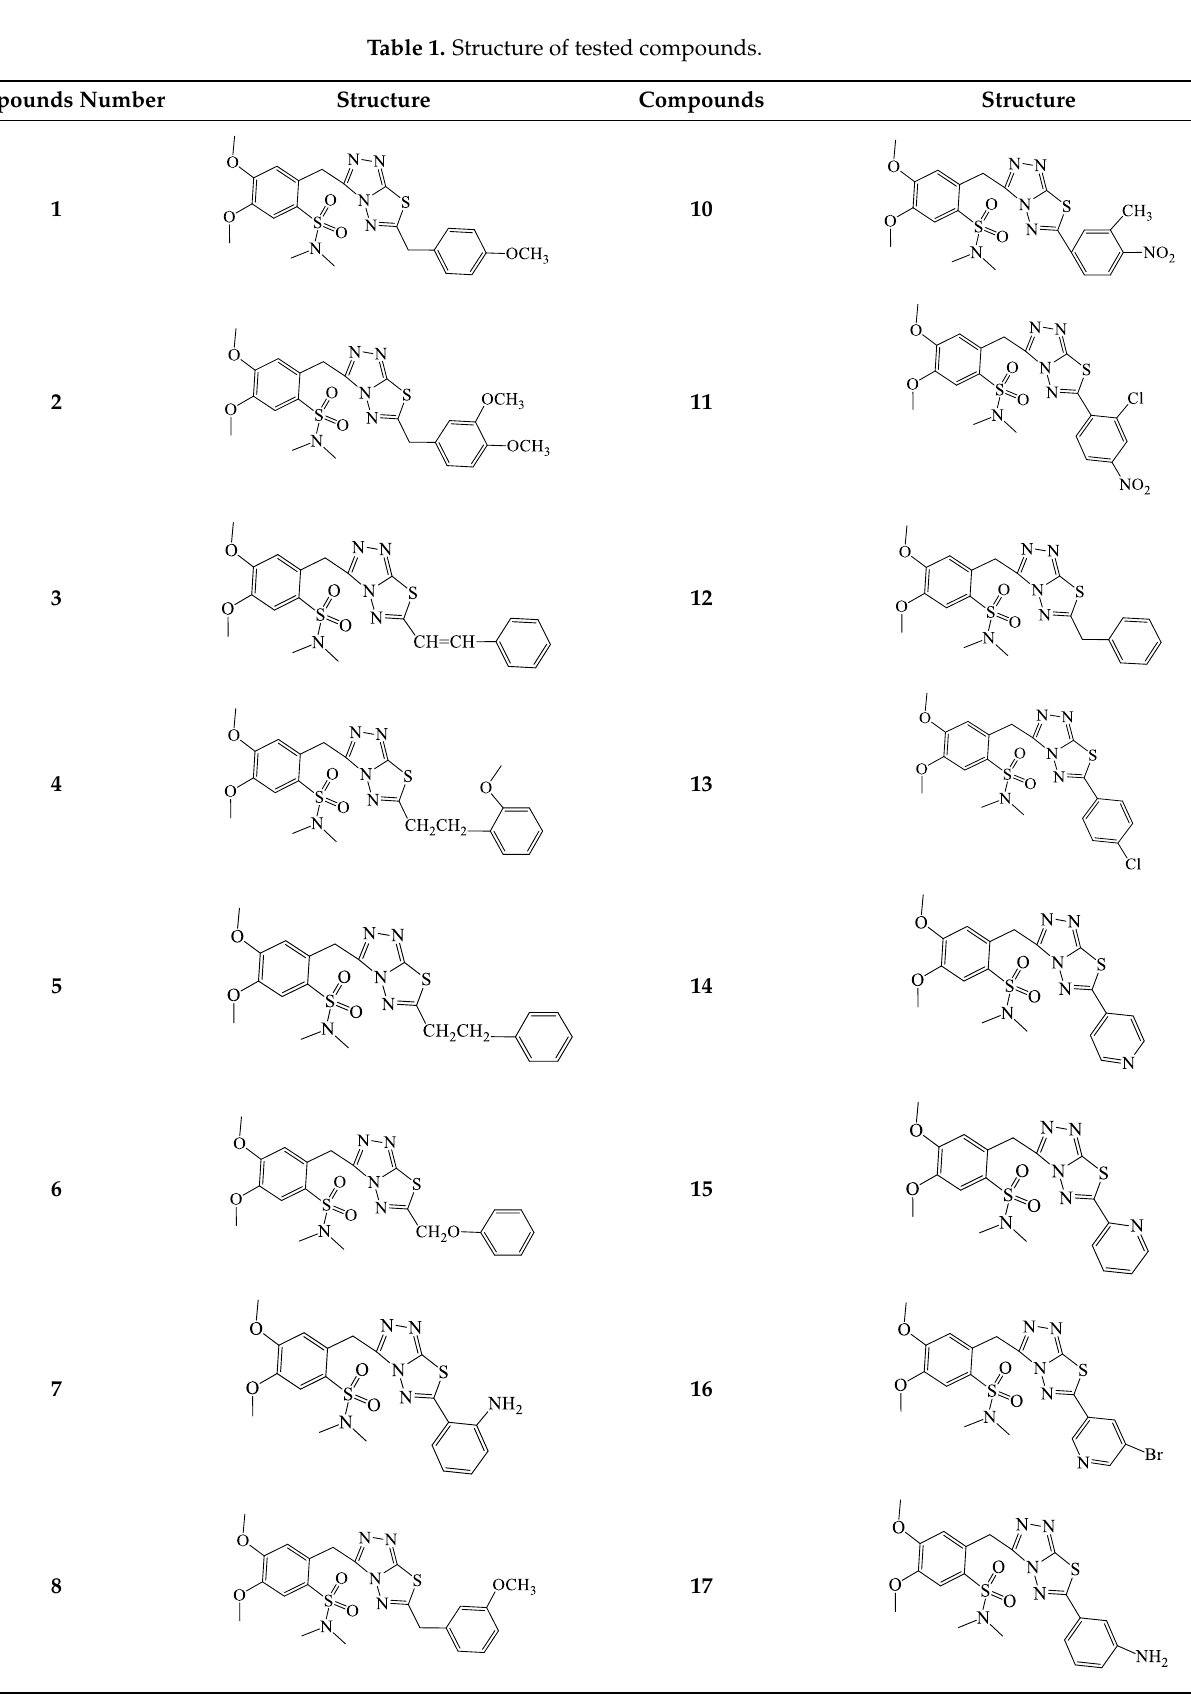
Table 1. Structure of tested compounds.